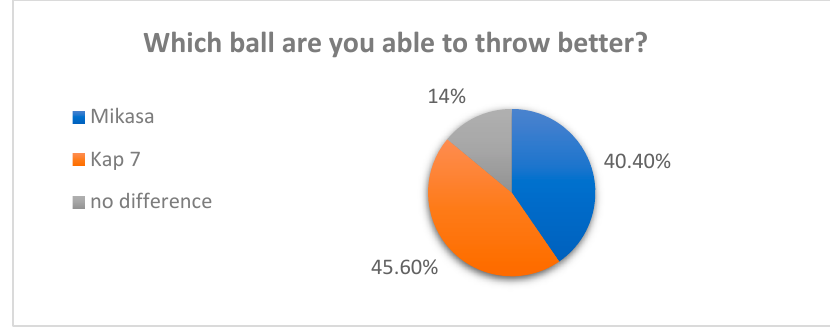
Figure 2. Throw assessment—survey results. When asked which used ball retains its properties better, 47.4% of respondents chose Mikasa, 42.1% chose Kap 7, and the rest did not feel any difference (Figure 3). The standard usage time of the ball is one season, about 10 months (500 h) according to players, after that time the ball is not fit for the game.